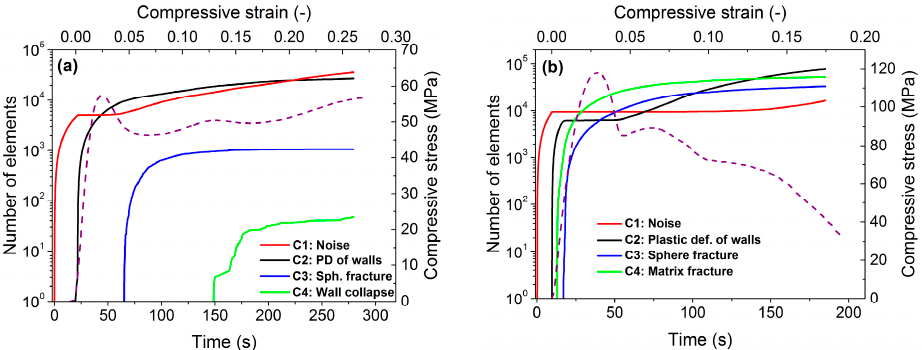
Figure 2. Time evolution of the cumulative number of elements in different AE clusters in ( a ) Al foam; ( b ) AlSi12 foam. Red line—noise; black—plastic deformation of matrix; blue—sphere fracture; green—Cluster 4: wall collapse in Al foam and brittle phase fracture of the matrix in AlSi12 foam. The stress-strain curve (dashed line) is also displayed.